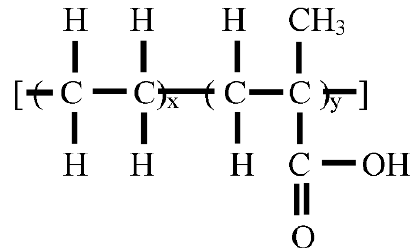
Figure 8. EMAA powder chemistry